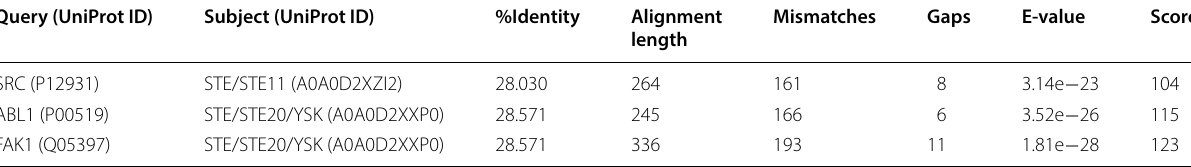
Table 5 Alignment results from the BLAST